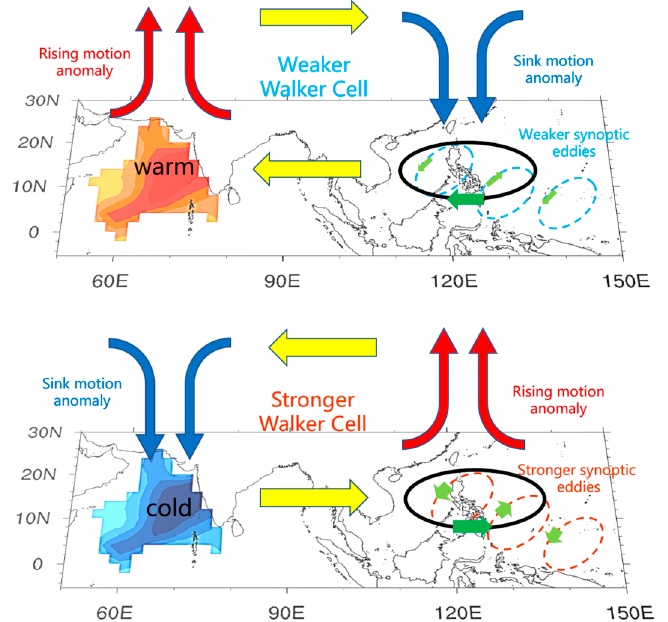
Figure 11. Schematic diagram. The upper panel shows the impact of warmer SSTs in the northwest Indian Ocean on synoptic eddies in the SCS-PS, while the lower panel shows the effect of cooler SSTs.